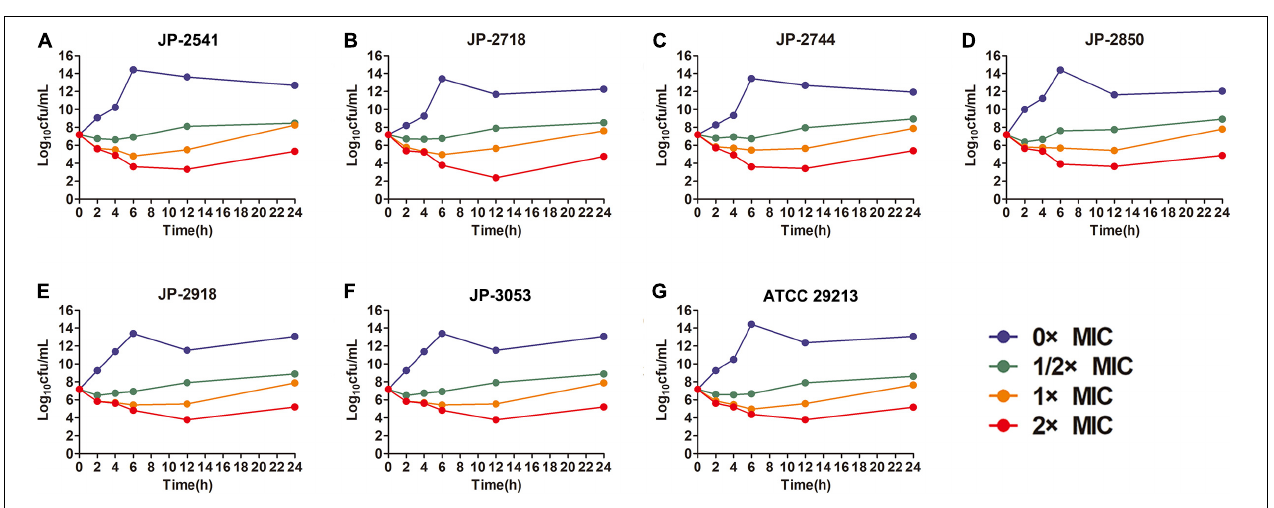
FIGURE 2 | Time-kill curves of different concentrations of CDB against Staphylococcus aureus . (A) time-kill curves for JP-2541; (B) time-kill curves for JP-2718; (C) time-kill curves for JP-2744; (D) time-kill curves for JP-2850; (E) time-kill curves for JP-2918; (F) time-kill curves for JP-3053; and (G) time-kill curves for S. aureus ATCC